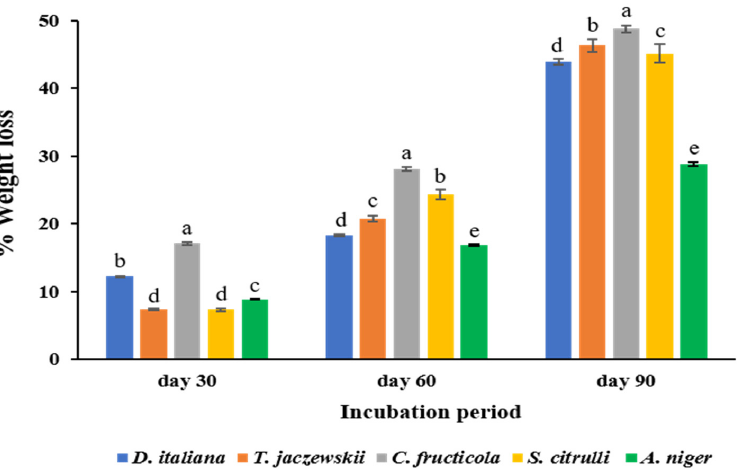
Figure 4. Weight loss percentage of LDPE films cultured with D. italiana , T. jaczewskii , C. fructicola , S. citrulli , and A. niger after 30, 60, and 90 days of incubation. Different letters above the bars indicate significant differences ( p <